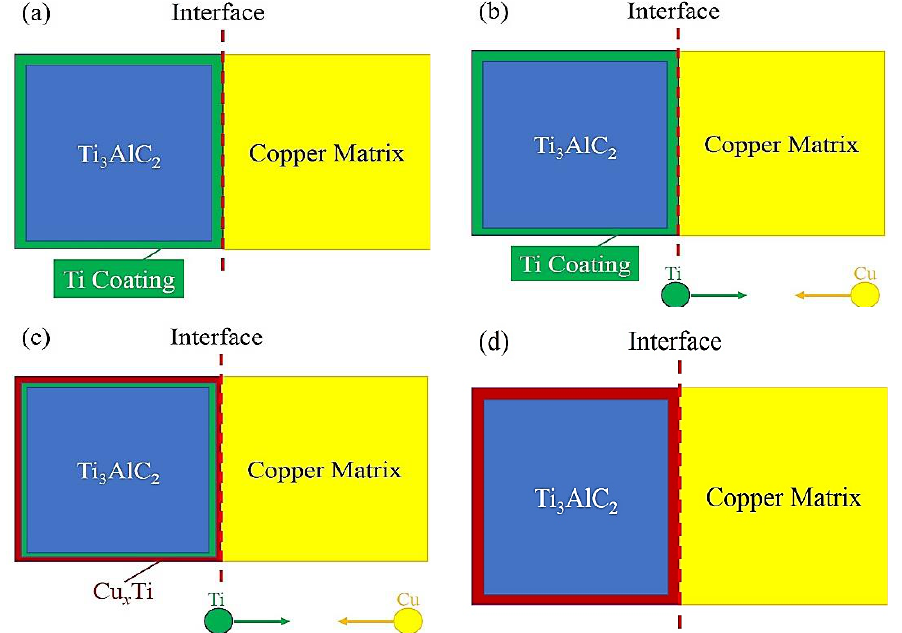
Figure 13. Model of the interface modification mechanism of Ti 3 AlC 2 : ( a ) the first stage: before sintering; ( b ) the second stage: at the beginning of sintering; ( c ) The third stage: the Ti coating reacts with Cu; ( d ) the fourth stage: the Ti coating reacts completely.